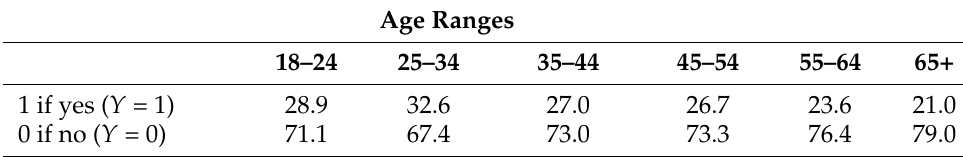
Table 5. Response distribution for dependent variable (in%).